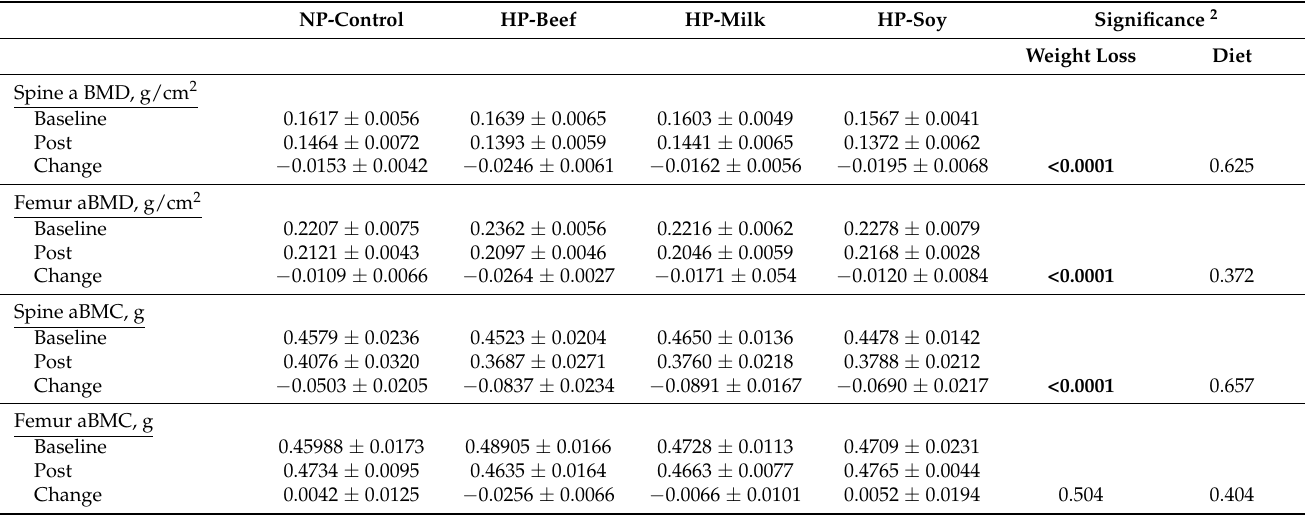
Figure 3. Changes in bone quantity (aBMD/BMC) of total right femur and lumbar spine over the 12-week weight loss intervention in a rat model of postmenopausal obesity. Weight loss decreased measurements of bone quantity independent of protein source and protein quantity. Mean delta values (Post-Baseline) ± SEM; Repeated Measures ANOVA, * Denotes significant effect of weight loss, p < 0.05. Table 4. Bone mineral density and bone mineral content changes following 12 weeks of energy restriction in obese ovariectomized Sprague Dawley females 1 .